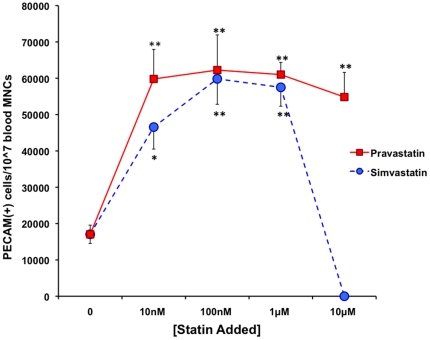
In Vitro Pravastatin and Simvastatin Promotes Outgrowth of LOEPCs from Blood Mononuclear Cells.Mononuclear cells were obtained from normal young pigs and cultured on type I collagen to derived LOEPCs. The quantity of LOEPCs per 3×107MNCs plated was determined using flow cytometry for PECAM positive cells after 14 days in culture. The data are presented as the means ± SEM from eight different animals. * p<0.05, ** p<0.01 vs. control using a paired t-test.